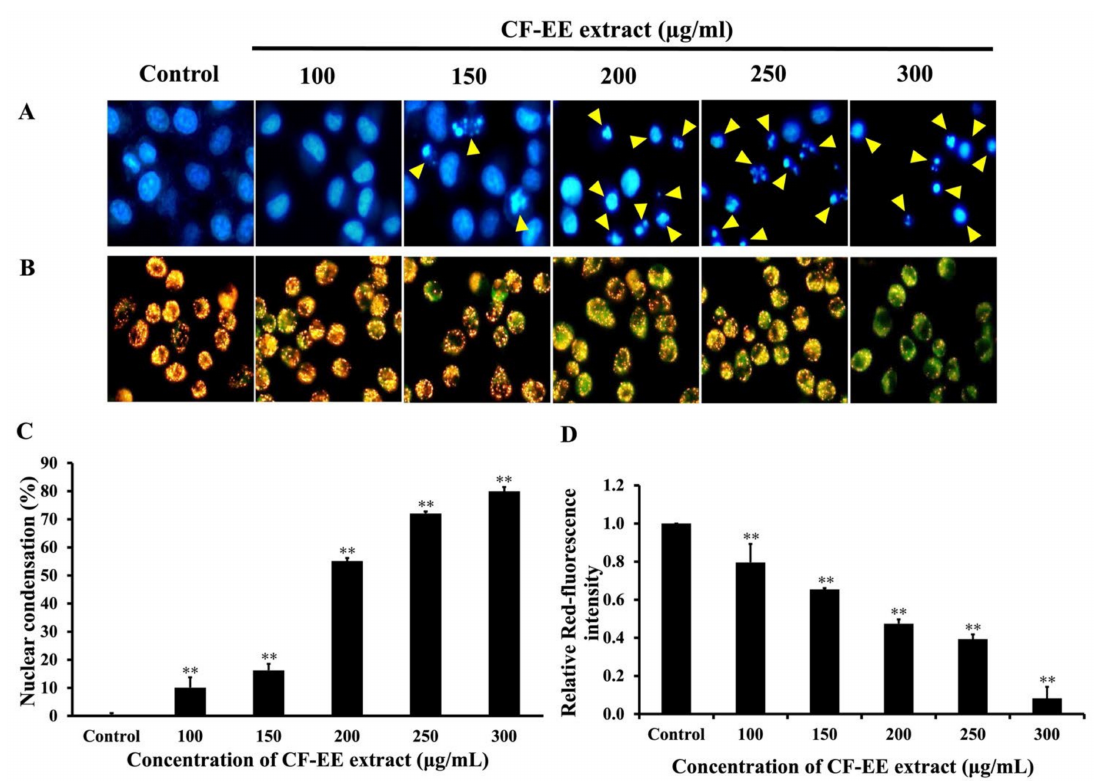
Figure 3. Effect of CF-EE extract on apoptosis induction in HeLa cells. ( A ) Nuclear morphological changes after Hoechst33342 staining observed by fluorescence microscopy (20X). Yellow arrow indicates nuclear condensed cells and apoptotic bodies. ( B ) Loss of mitochondrial membrane potential in CF-EE extract-treated cells observed by fluorescence microscopy (20 × ). ( C ) Percentage of nuclear condensation compared to the control. ( D ) Relative red-fluorescence intensity compared to the control. The values are represented as the mean ± SD. ** p < 0.01 compared to the